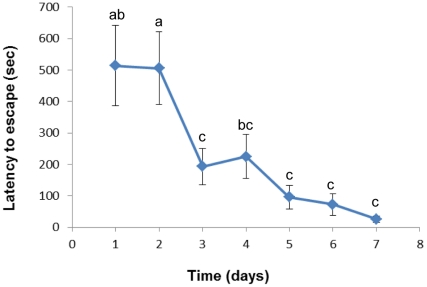
Reduction in latency to escape of T fish over the 7 days of CS-US pairing. Each point represents the mean ± SE of 24 individuals. Different letters denote statistical significance at a significant level of p<0.05 after repeated ANOVA and Bonferroni comparisons.